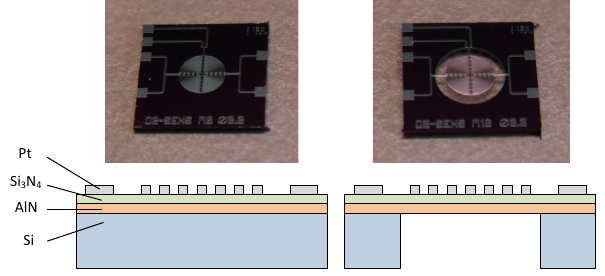
Figure 2. Cross sectional view and fabricated sensors with a diameter of 2.2mm on bulk silicon (left) and on an AlN membrane (right).